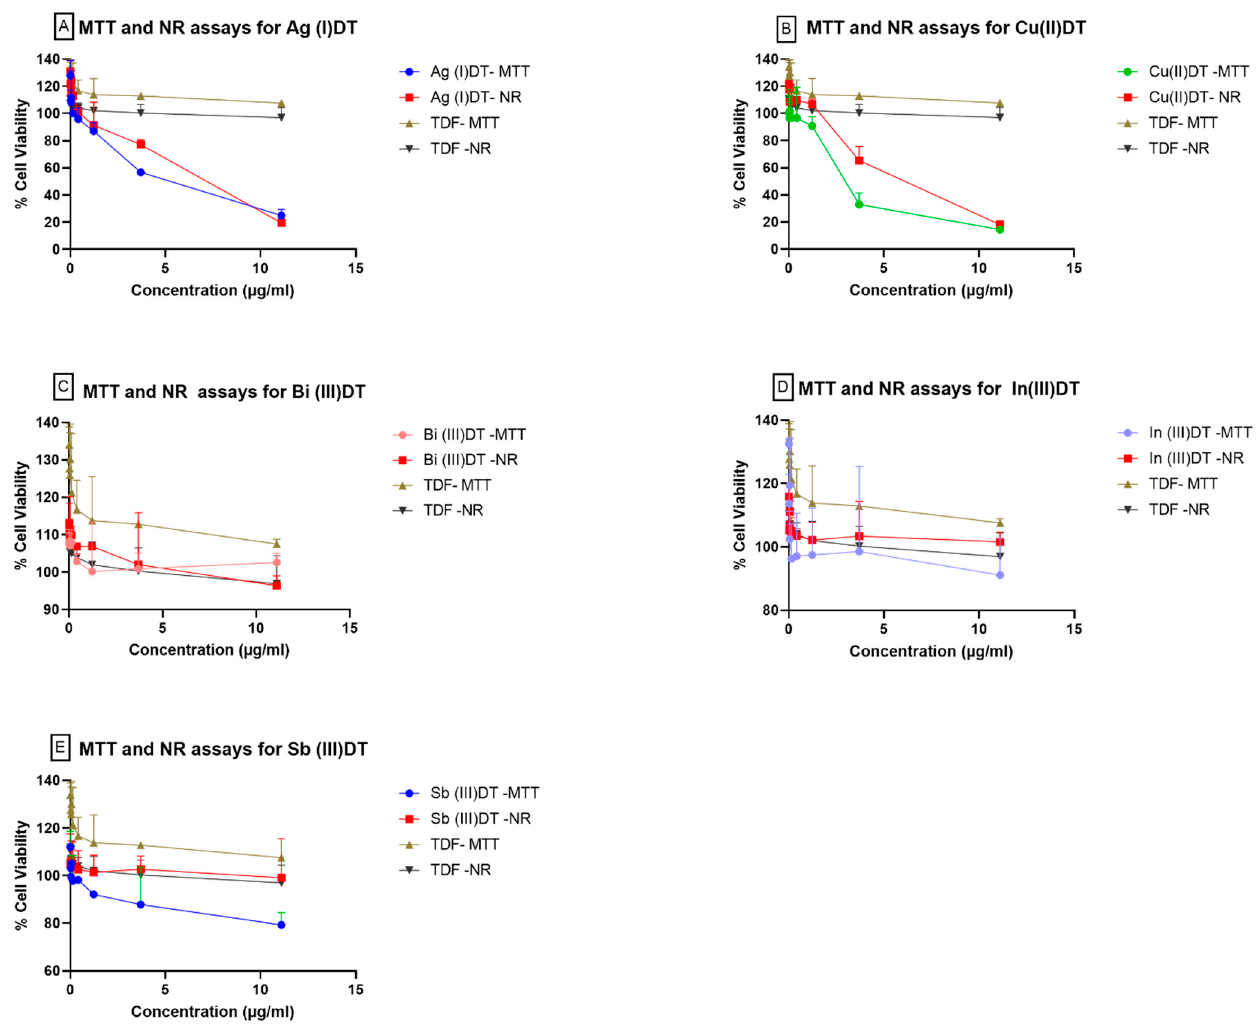
Figure 9. TZM-bl cell viability assessment of N -methyl- N -phenyl dithiocarbamate complexes of silver(I), bismuth (III), copper (II), indium (III), and antimony (III) using ( A – E ) MTT and neutral red